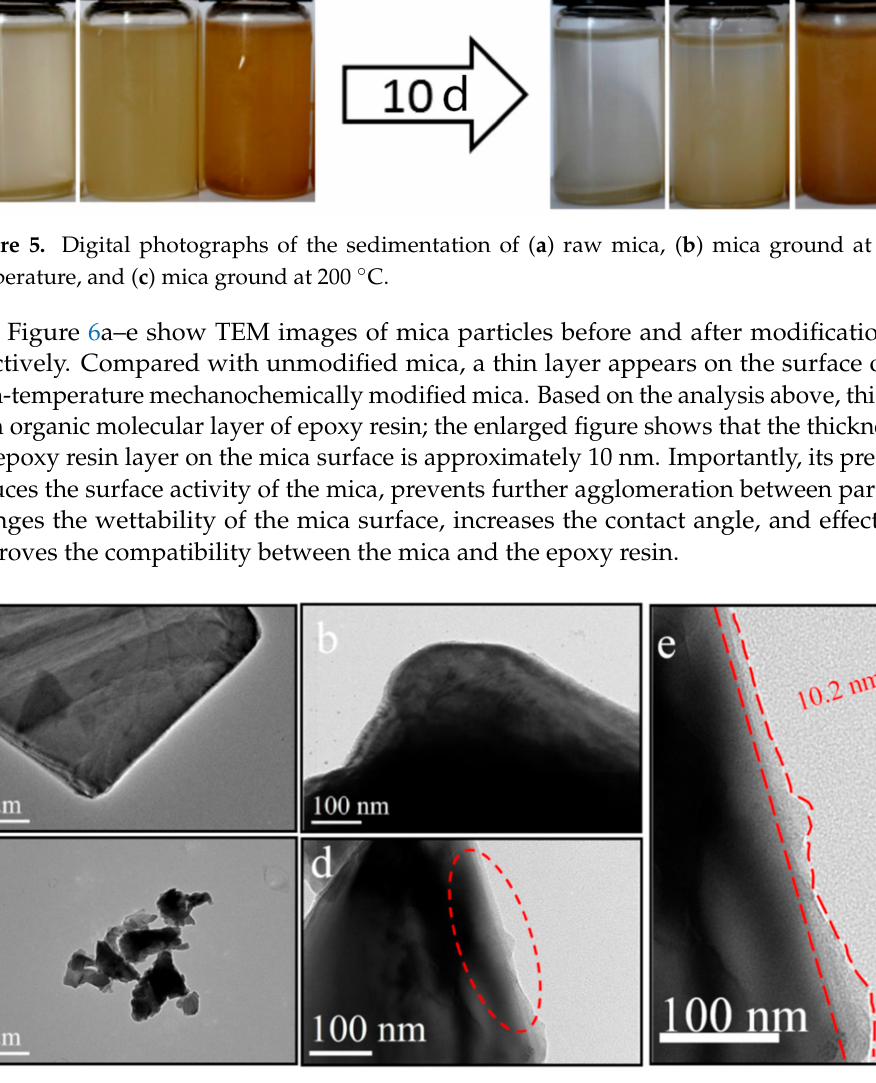
Figure 6. TEM images of ( a , b ) unmodified mica, and ( c – e ) modified